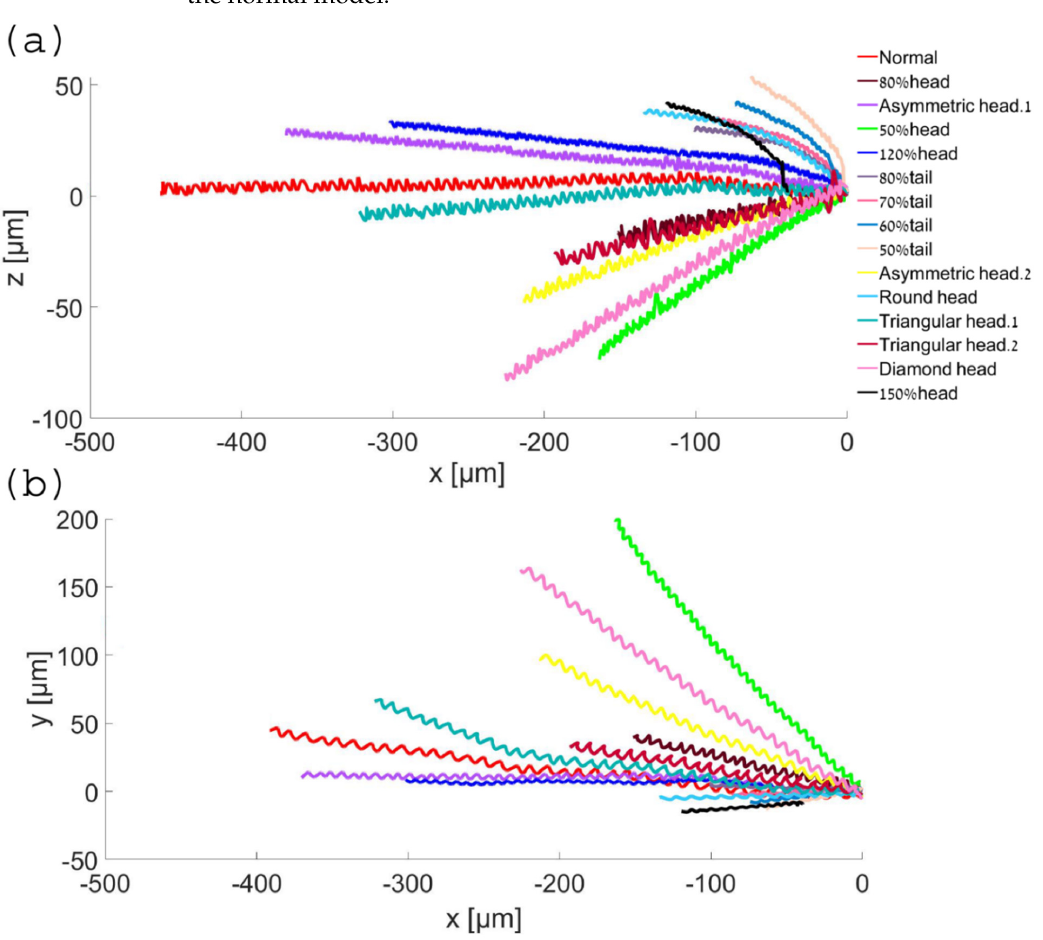
Figure 6. Normal and abnormal model swimming patterns. Two-dimensional trajectories in the forward direction ( a ) and in the upward direction ( b ).